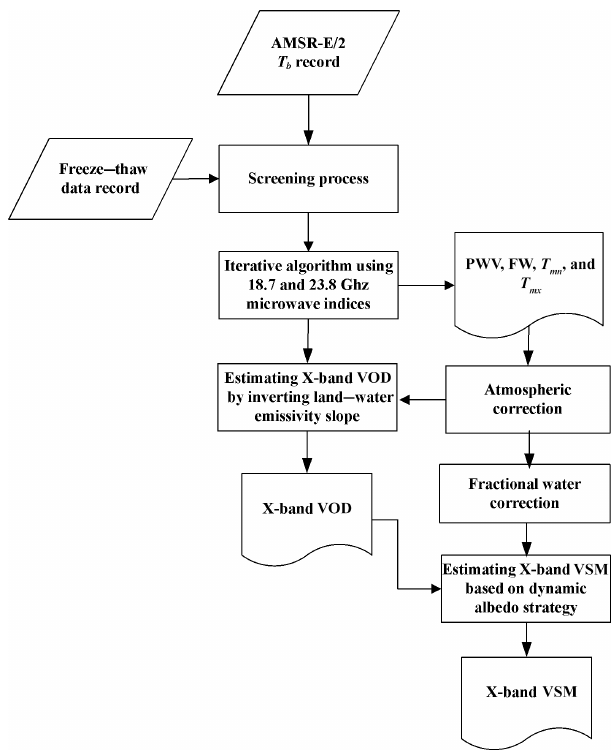
Figure 1. The LPDR algorithm retrieval